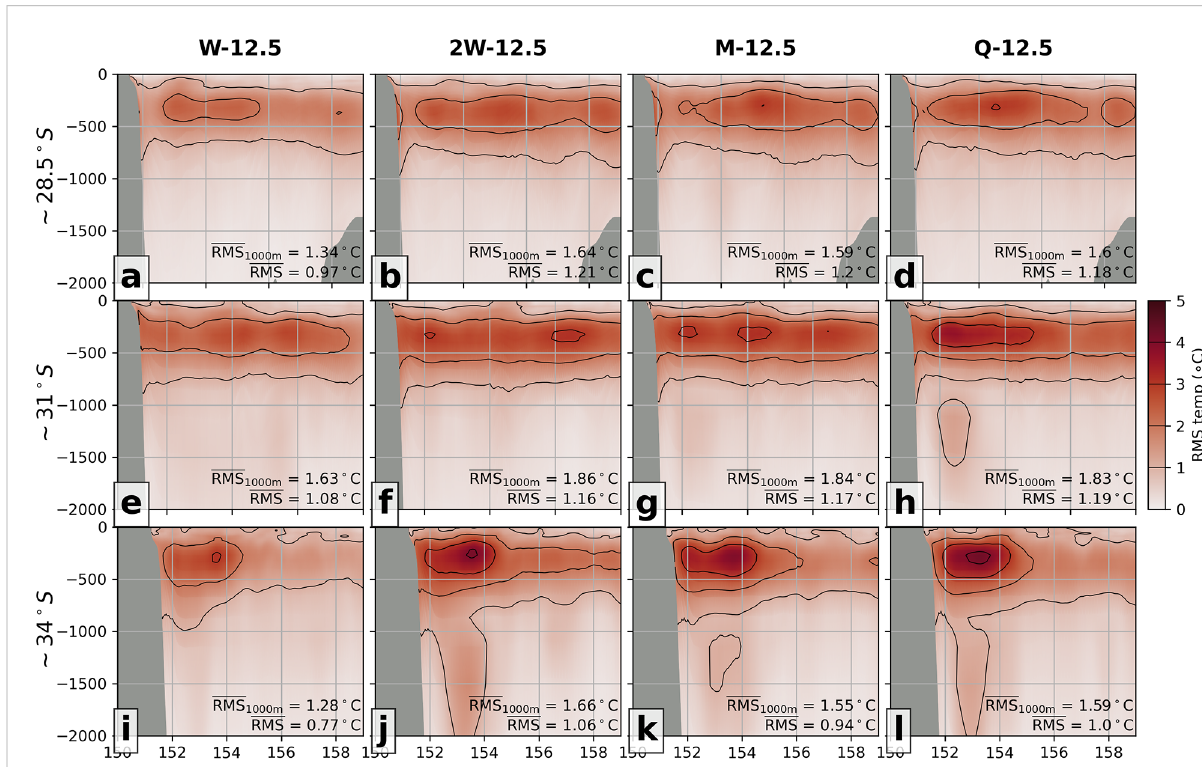
FIGURE 6 The RMS error in temperature, calculated for the time-mean, at the (A – D) XBT-N transect, (E – H) the mid-coast analysis transect, and (I – L) XBT-S transect, for the four different OSSEs: (A, E, I) Weekly 12.5 km, (B, F, J) Two-weekly 12.5 km, (C, G, K) Monthly 12.5 km and (D, H, L) Quarterly 12.5. RMS error is relative to the ref state, and mean values are shown in each panel for full-depth and the top 1000 m. The contour interval of 1°C is indicated with marks in the